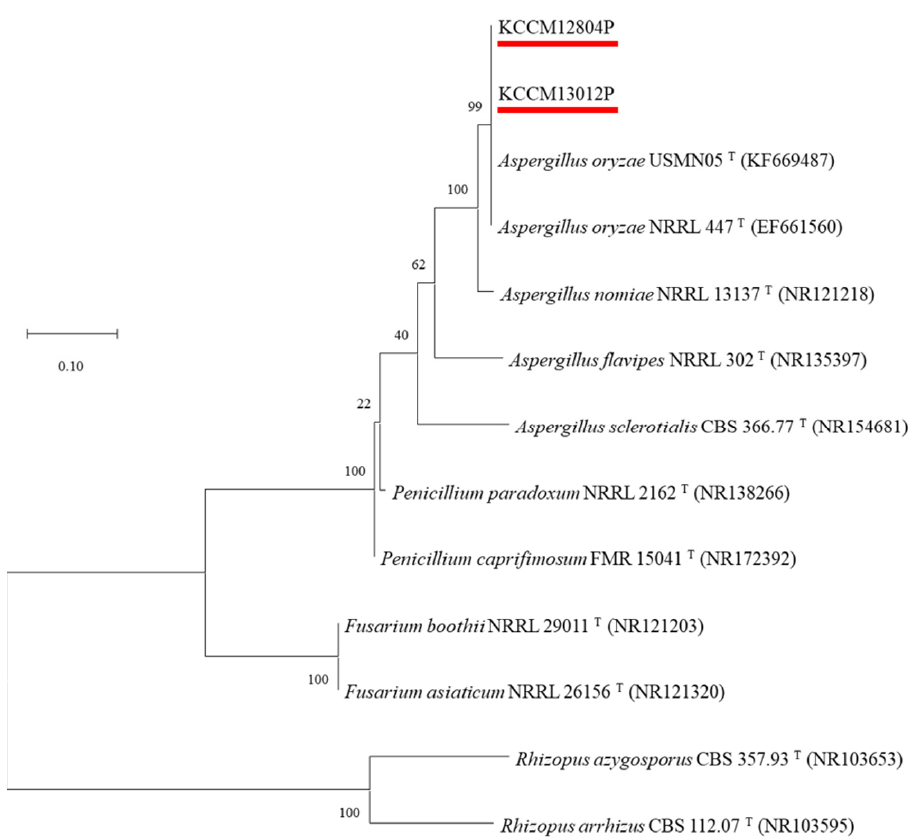
Figure 1. Phylogenetic tree based on internal transcribed spacer sequence (ITS-1) of KCCM13012P and KCCM12804P, and other Aspergillus type strains. GenBank accession numbers are given in parentheses and the branching pattern was generated by the maximum likelihood method. Bar means 0.10 substitutions per nucleotide position, and bootstrap values are expressed as percentages of 1000 replicates.